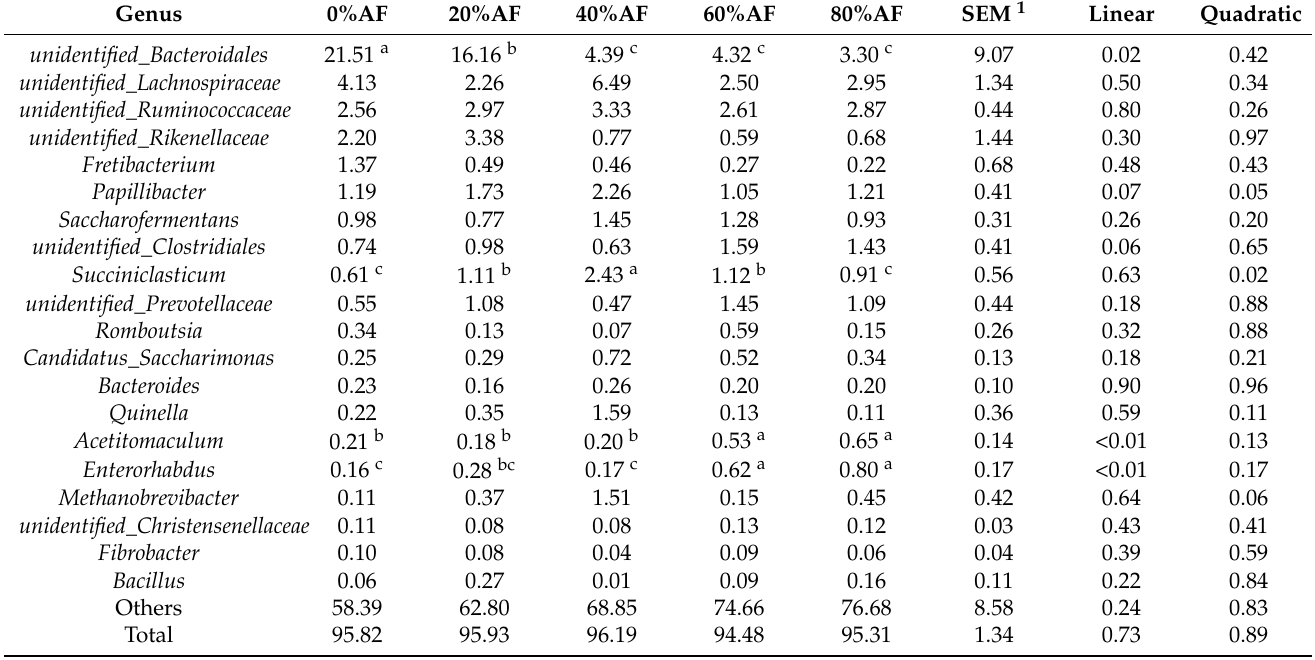
Table 6. Composition and relative abundance of rumen bacterial communities at genus.